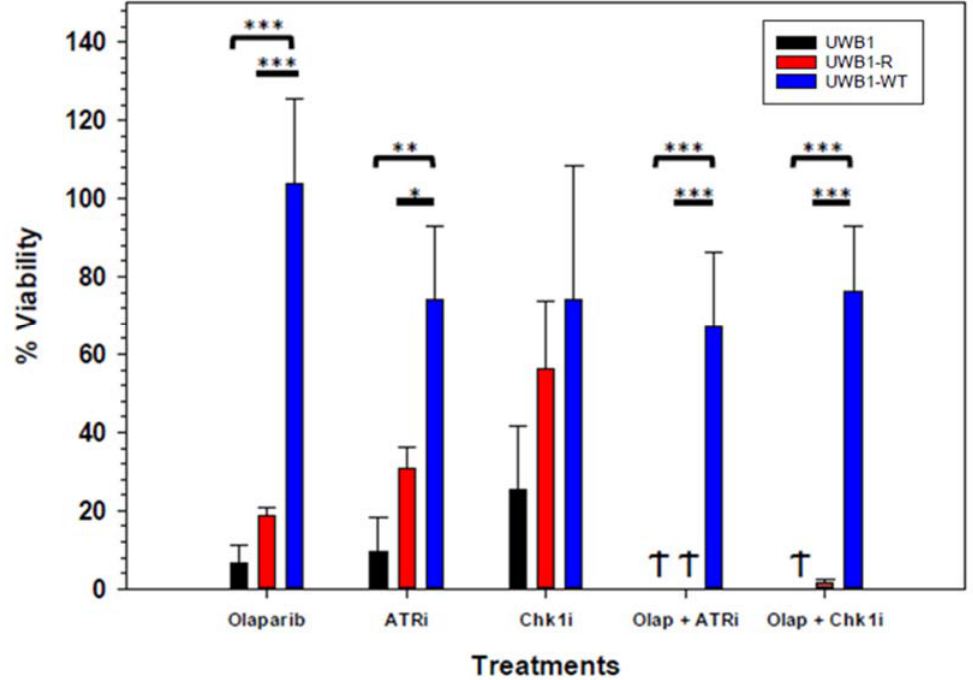
Figure 4. Cell viability after 21 days exposure to olaparib (1 µ M), ATRi (0.8 µ M), Chk1i (0.5 µ M), and combination treatments with olaparib (1 µ M) + ATRi (0.8 µ M) and olaparib (1 µ M) + Chk1i (0.5 µ M). Olaparib treatment: UWB1 and UW1 ‐ R cells were significantly more sensitive to olaparib and ATRi ( p = 0.002). ATR treatment: Cell viability for UWB1 ‐ R ( p = 0.002) and UWB1 ‐ WT cells ( p = 0.02) were significantly less compared to UWB1 cells. Chk1 treatment: Increasing cell viability trend is noted for UWB1 ‐ R compared to UWB1 followed by UWB1 ‐ WT. The magnitude of the differences was not statistically significant. Olap + ATRi treatment: Cell viability was significantly less in UWB1 (0%) and UWB1 ‐ R cells (0%) compared to UWB1 ‐ WT (67 ± 19%) ( p = 0.0005). Olap + Chk1 treatment: Cell viability for UWB1 (0%) and UWB1 ‐ R (1.4 ± 1%) was significantly less compared to UWB1 ‐ WT (76.4 ± 16%) ( p = <0.0001). Experiments were completed in triplicate with standard deviation error bars shown. α < 0.05 = *, α < 0.01 = **, α < 0.001 = ***.